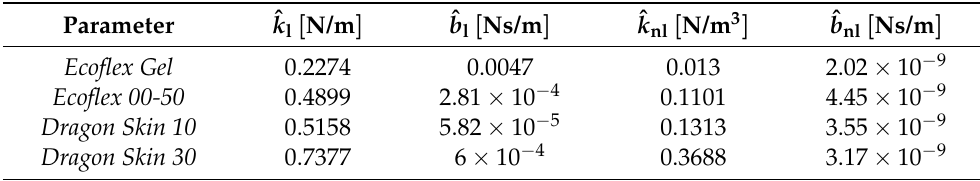
Table 1. Mean values µ of the estimated parameters.